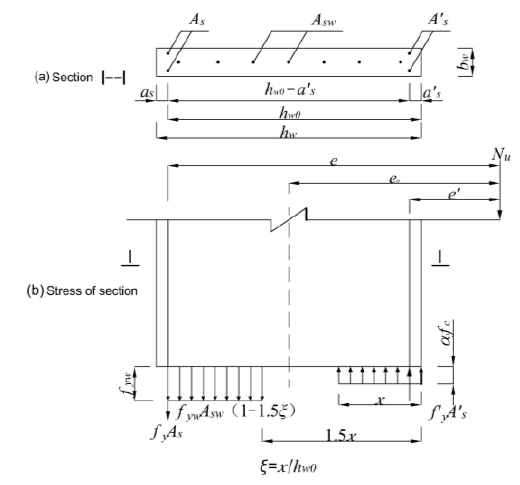
Figure 17. Calculating diagram of large eccentric compression.